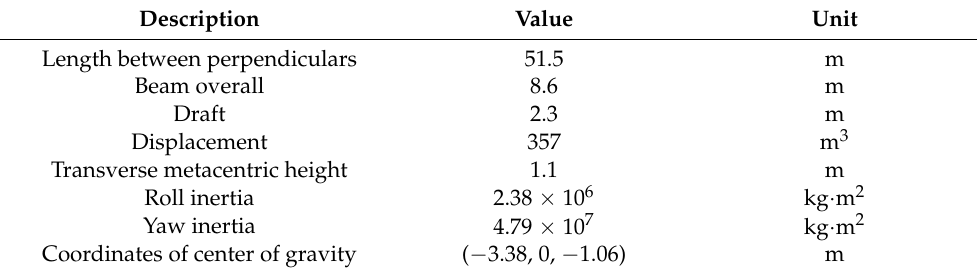
Table 1. Parameters of the vessel.